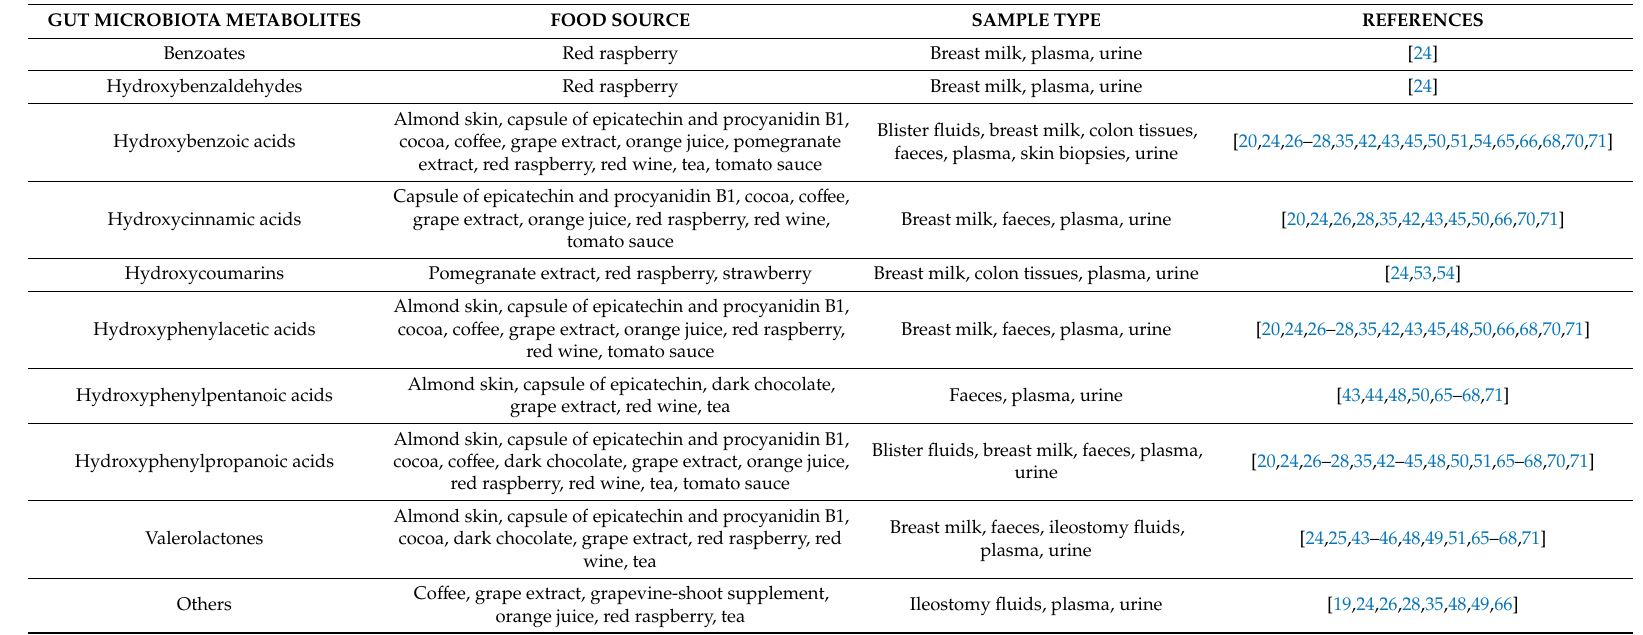
Table 1. Principal MPM groups found in biological fluids after feeding trials in